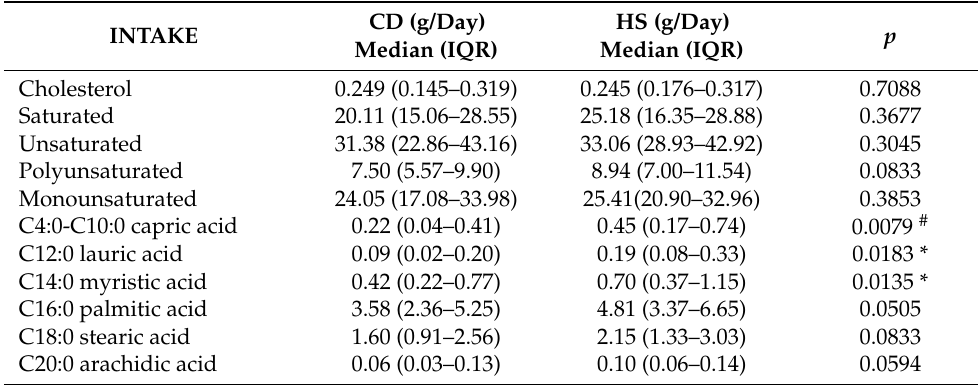
Table 2. Levels of intake for the main dietary